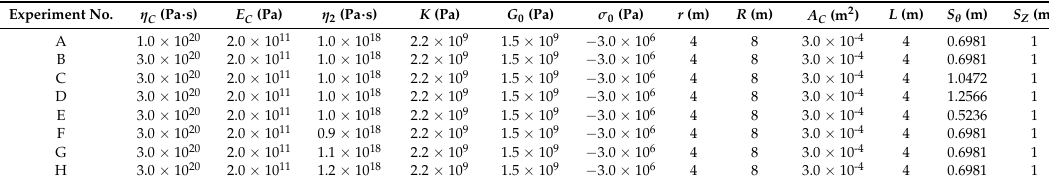
Table 1. Experiment